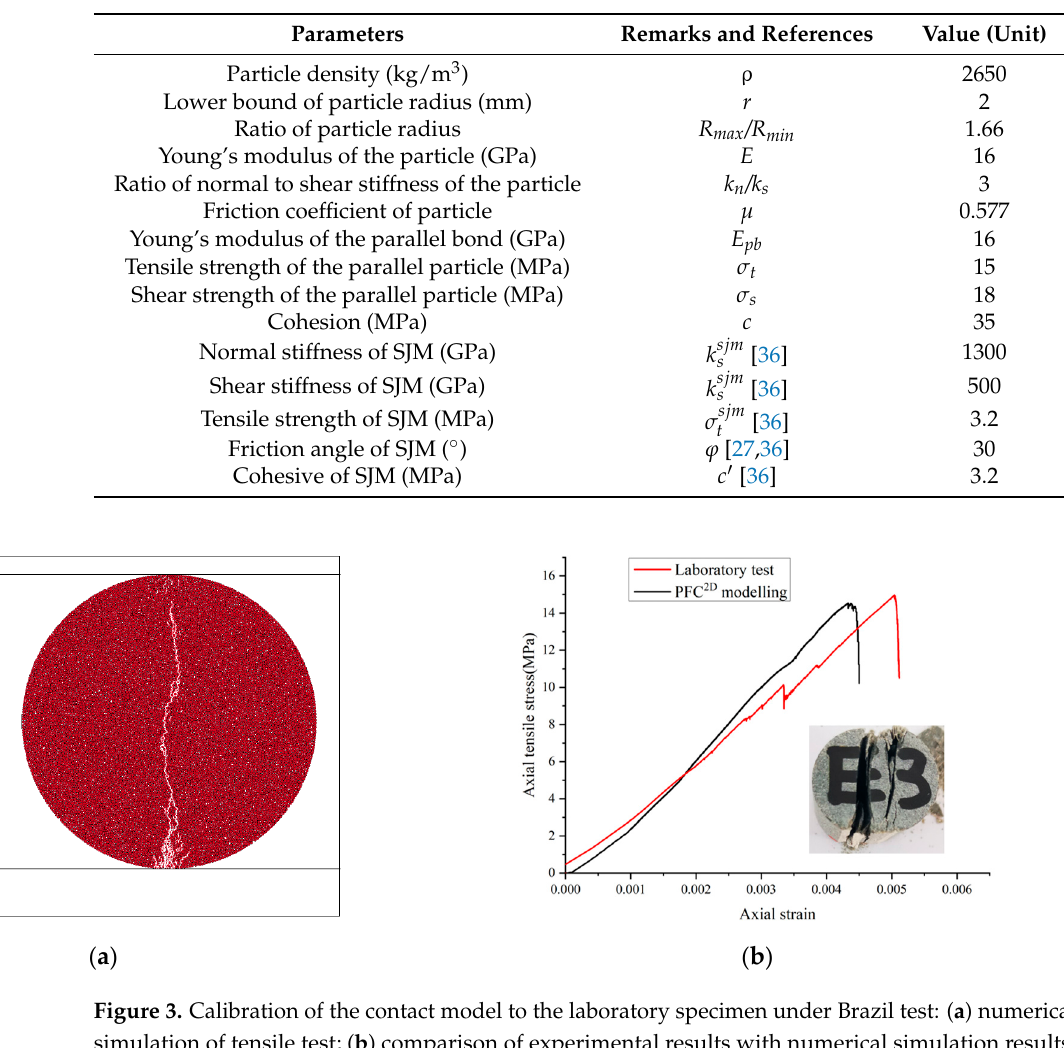
Figure 2. Calibration of the contact model to the laboratory specimen under UCS test: ( a ) numerical simulation of UCS test; ( b ) comparison of experimental results with numerical simulation results. Table 2. Calibrated microscopic properties of the sandstone model.